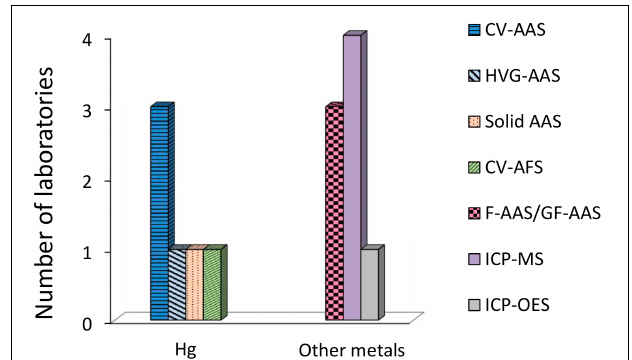
FIGURE 4 | Analytical methods used for metal analysis in sediment by the different laboratories. CV-AAS, Cold Vapor Atomic Absorption Spectrometry;